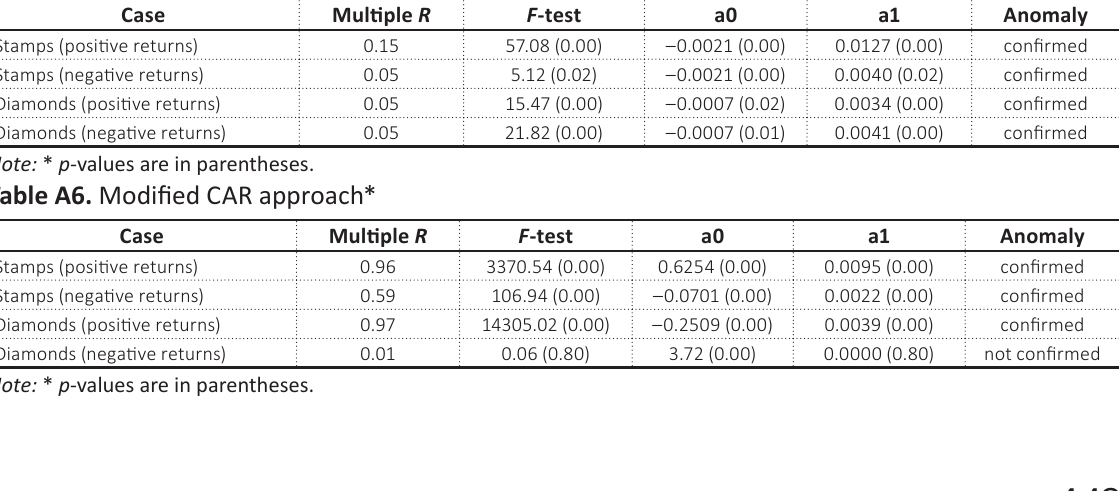
Table A5. Regression analysis with dummy variables*